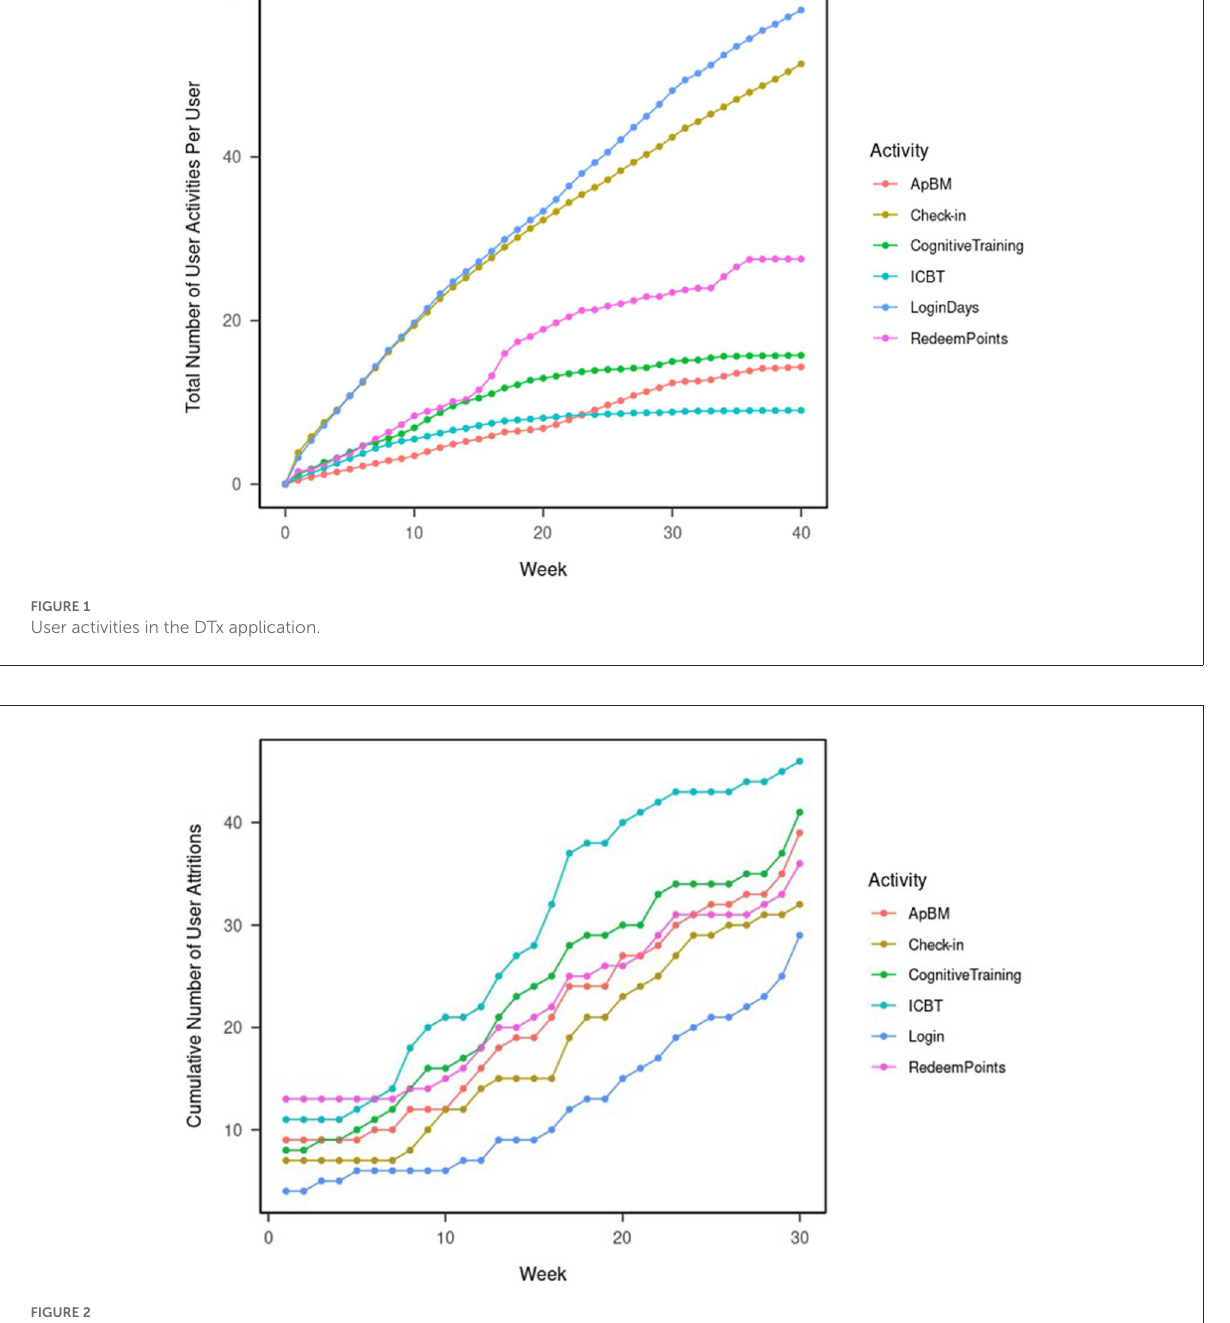
By the end of week 24, 9 users (17.3%) were still viewing ICBT sessions, 18 users (34.6%) were still completing cognitive trainings, 21 users (40.4%) were redeeming points, 21 users (40.4%) were still doing